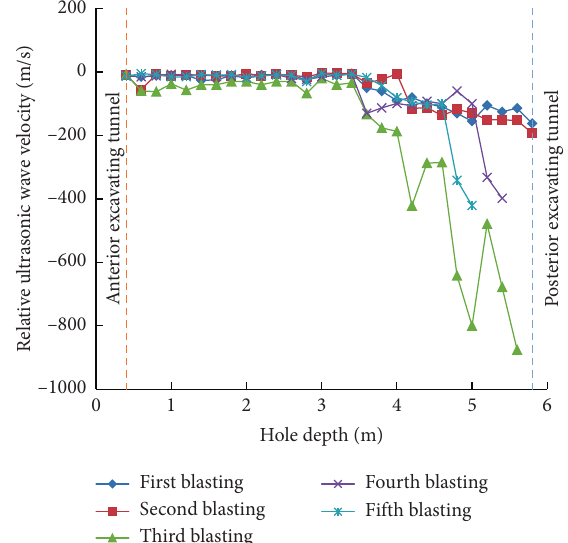
Figure 11: Relation curves between relative ultrasonic wave ve- locity and hole depth ( L 2).